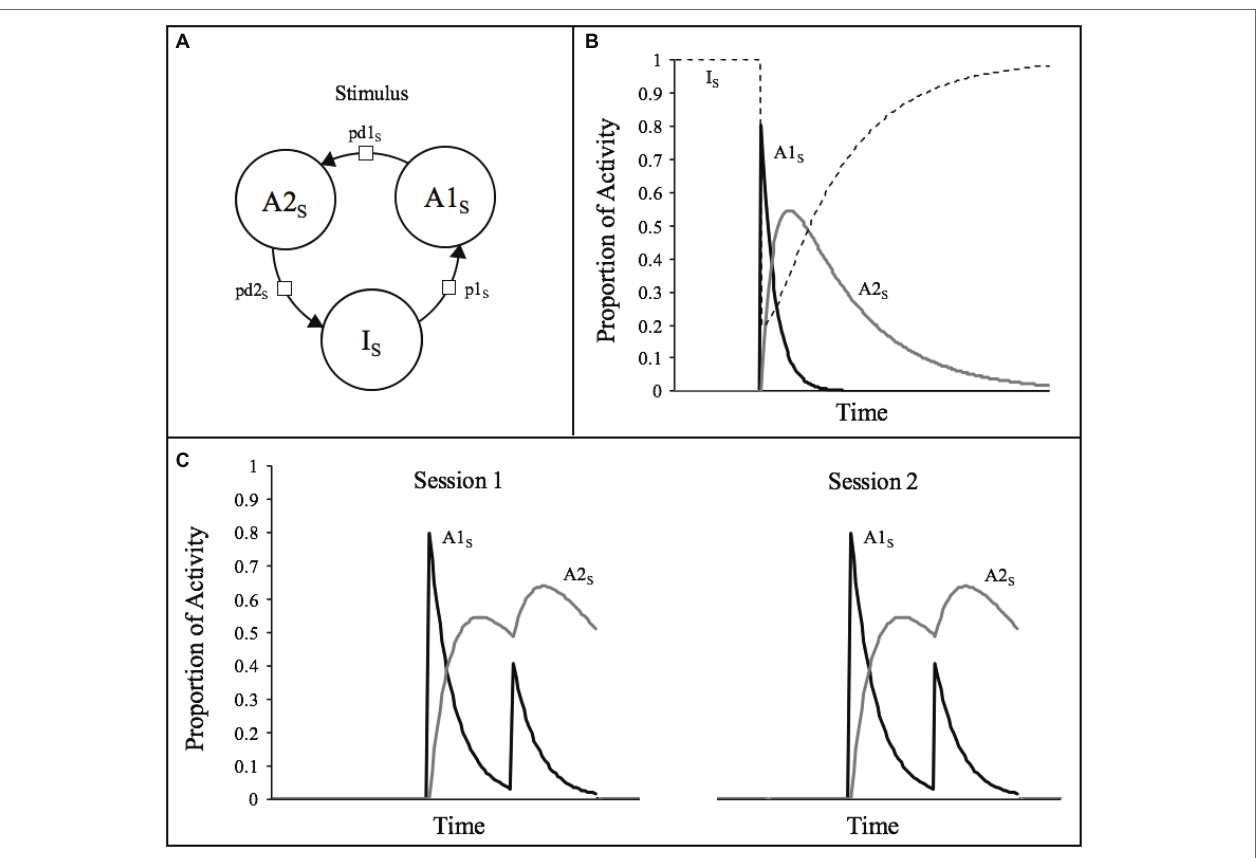
FIGURE 1 | (A) The three possible activity states for a stimulus representation assumed by SOP. (B) Courses of activity for a typical stimulus (s; duration = 1 moment, p 1 S = 0.8, pd 1 S = 0.1, pd 2 S = 0.02) according to SOP rules of activity. (C) Simulations of the theoretical processes involved in two training sessions of two presentations of a 1-moment